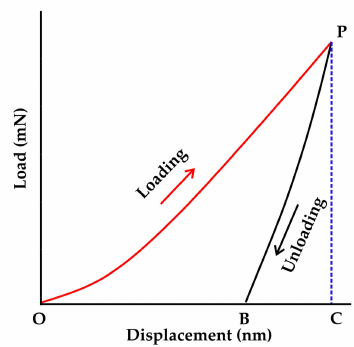
Figure 6. The load-displacement curve of the nanoindentation test.